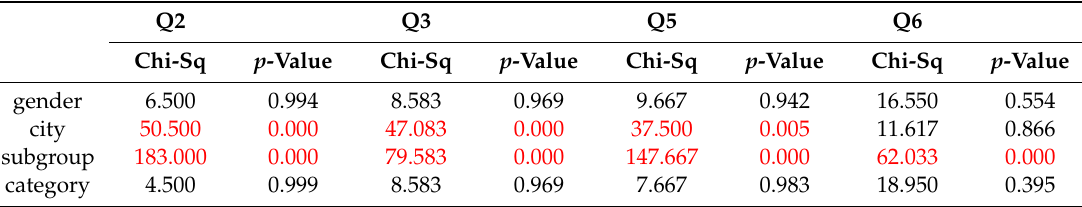
* the color red in the table indicates statistically important results with p < 0.05.